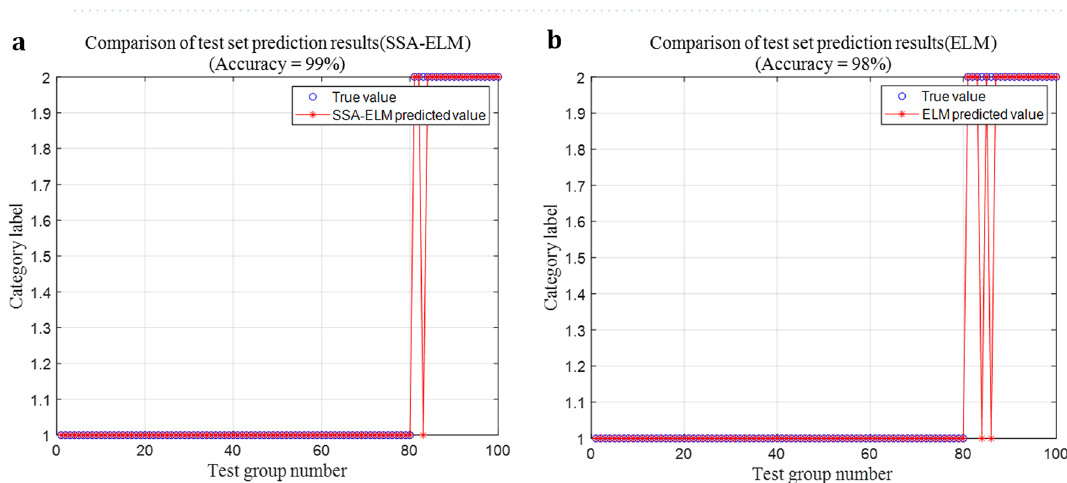
Figure 10. Convergence curve of SSA-ELM.